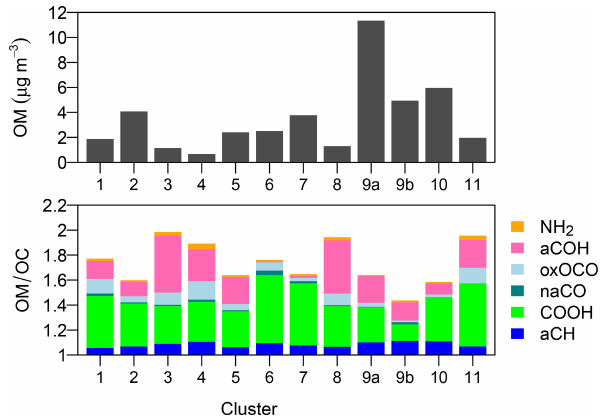
Figure 6. Comparison of reference TOR OC measurements and FG-OC estimated by Bayesian calibration. FG-OC corresponds to the mode of the posterior predictive distribution ˜ y (Sect. S4). The lines span the 95% uncertainty intervals in TOR measurements hor- izontally and 95% prediction intervals of the posterior distribution vertically. Diagonal line corresponds to 1:1 relation, and the dot- ted red line corresponds to the best-fit line (Pearson’s r = 0 . 96; slope = 0 . 87; intercept = 0 . 04µgm − 3 ).